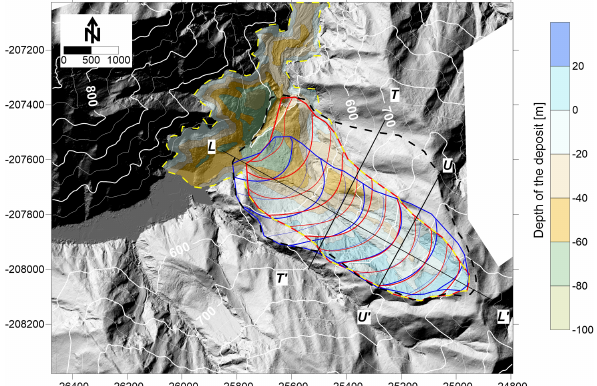
Figure 15. Akatani hillshade post-DEM (1m) and contour (5m) of the depth of the deposit based on the comparison between the mixed scenario and the post-DEM results.